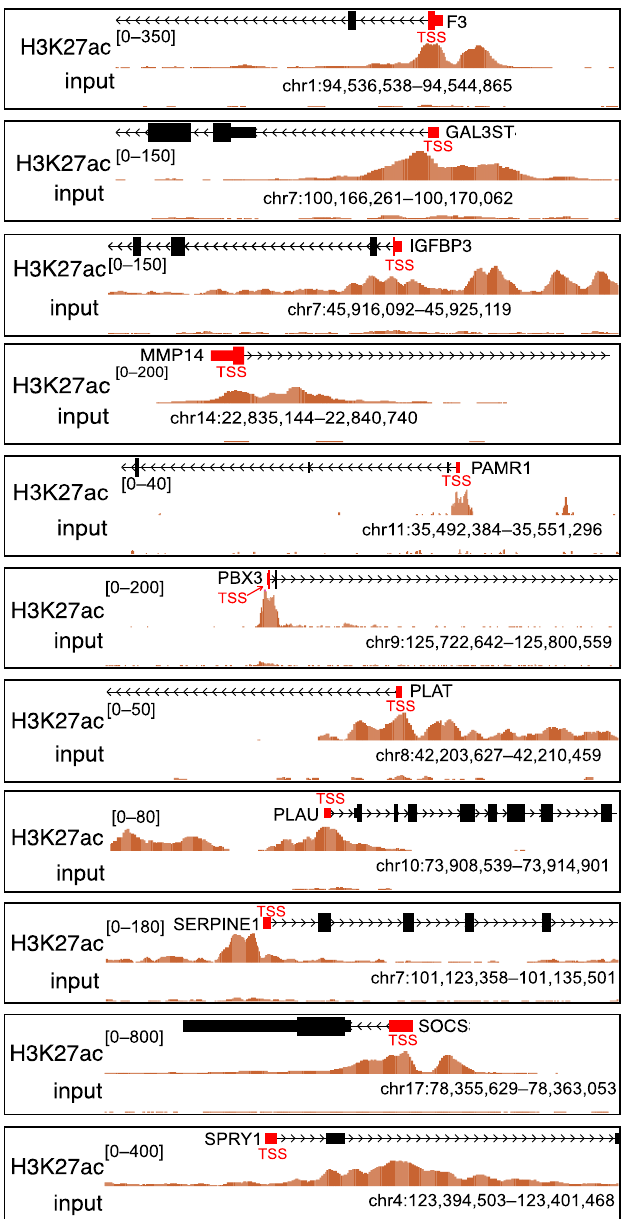
Figure 5. H3K27ac ChIP-seq peaks at TSSs in 11 candidate genes. Abbreviations: H3K27ac, histone H3 lysine 27 acetylation; ChIP-seq, chromatin immunoprecipitation-sequencing; TSS, transcription start site.